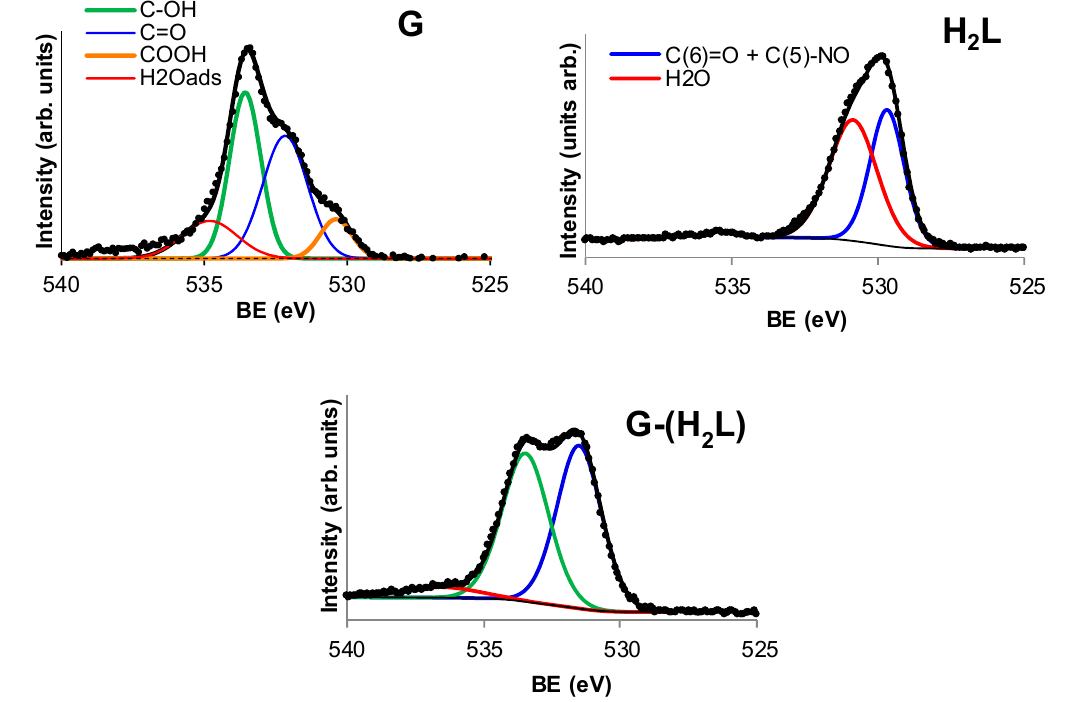
Figure 5. N1s signals of the X-ray photoelectron spectra (XPS) of H 2 L, G-(H 2 L) and G-(H 2 L)-Pd.